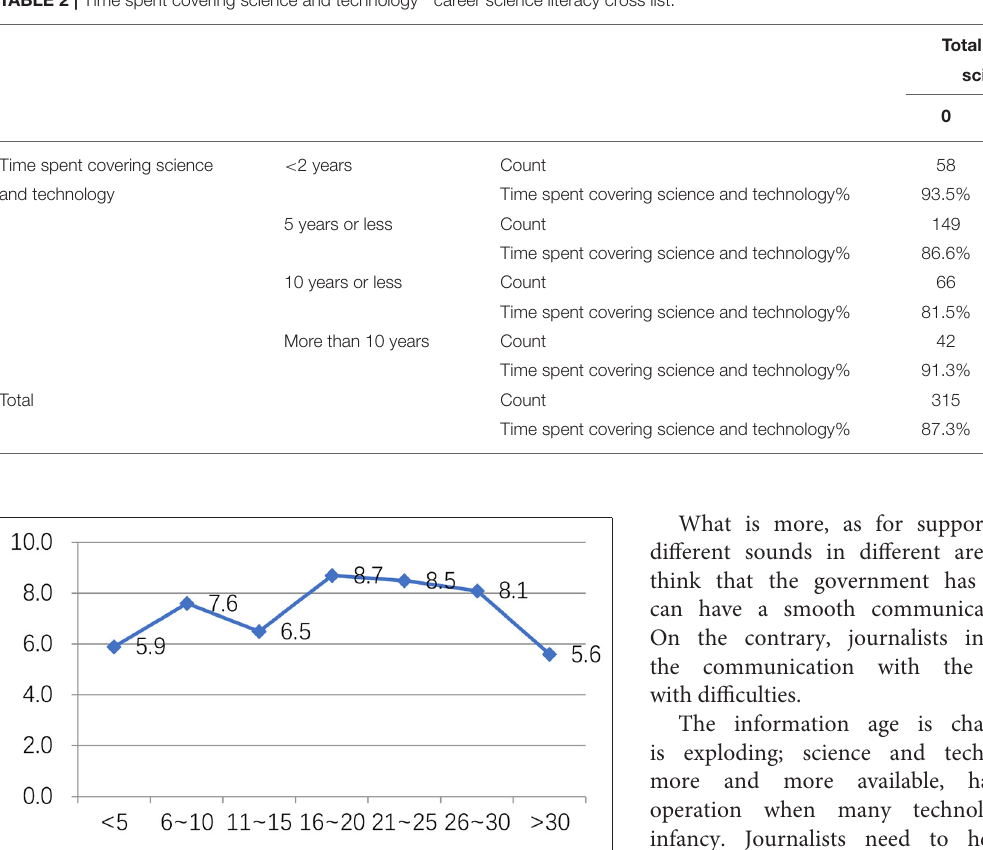
TABLE 2 | Time spent covering science and technology * career science literacy cross list.